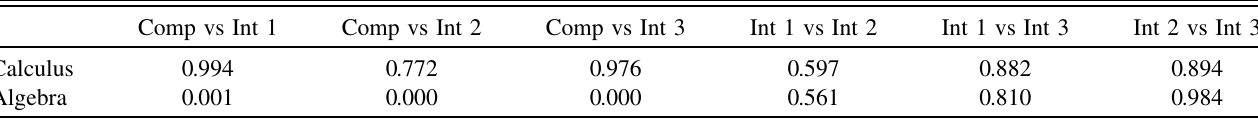
IX. The p values for the comparison of students’ performance between the comparison group (Comp) and different intervention (Int) groups in the calculus-based and algebra-based